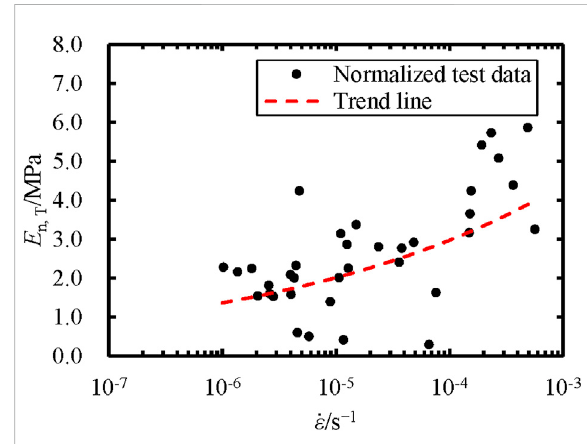
FIGURE 11 Normalized effective elastic modulus E n, T versus strain rate _ ε for ice